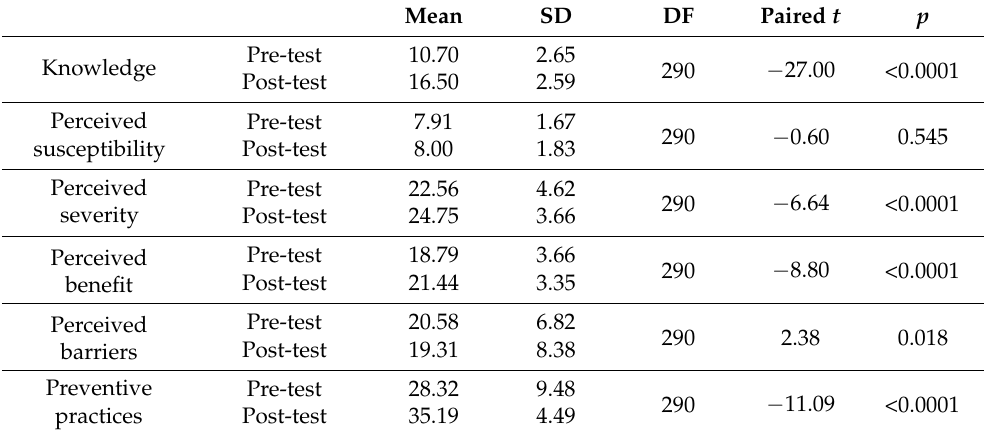
Table 3. Paired t test for total scores of knowledge, health beliefs, and preventive practices toward mosquito-borne diseases before and after the implementation of the health education program. Mean SD DF Paired t